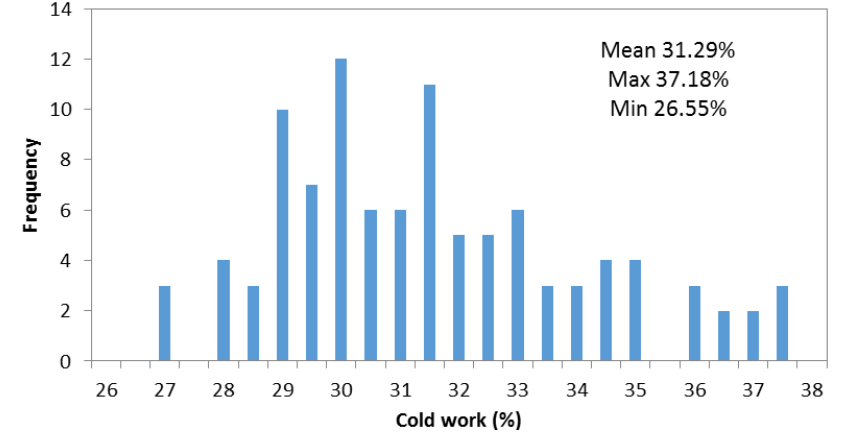
Figure 3. Associated cold work statistics.